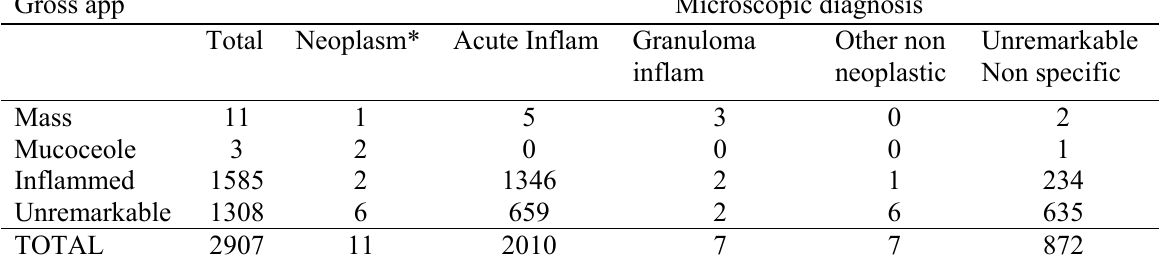
Table 2 . Correlation of gross appearances of appendices with microscopic features in